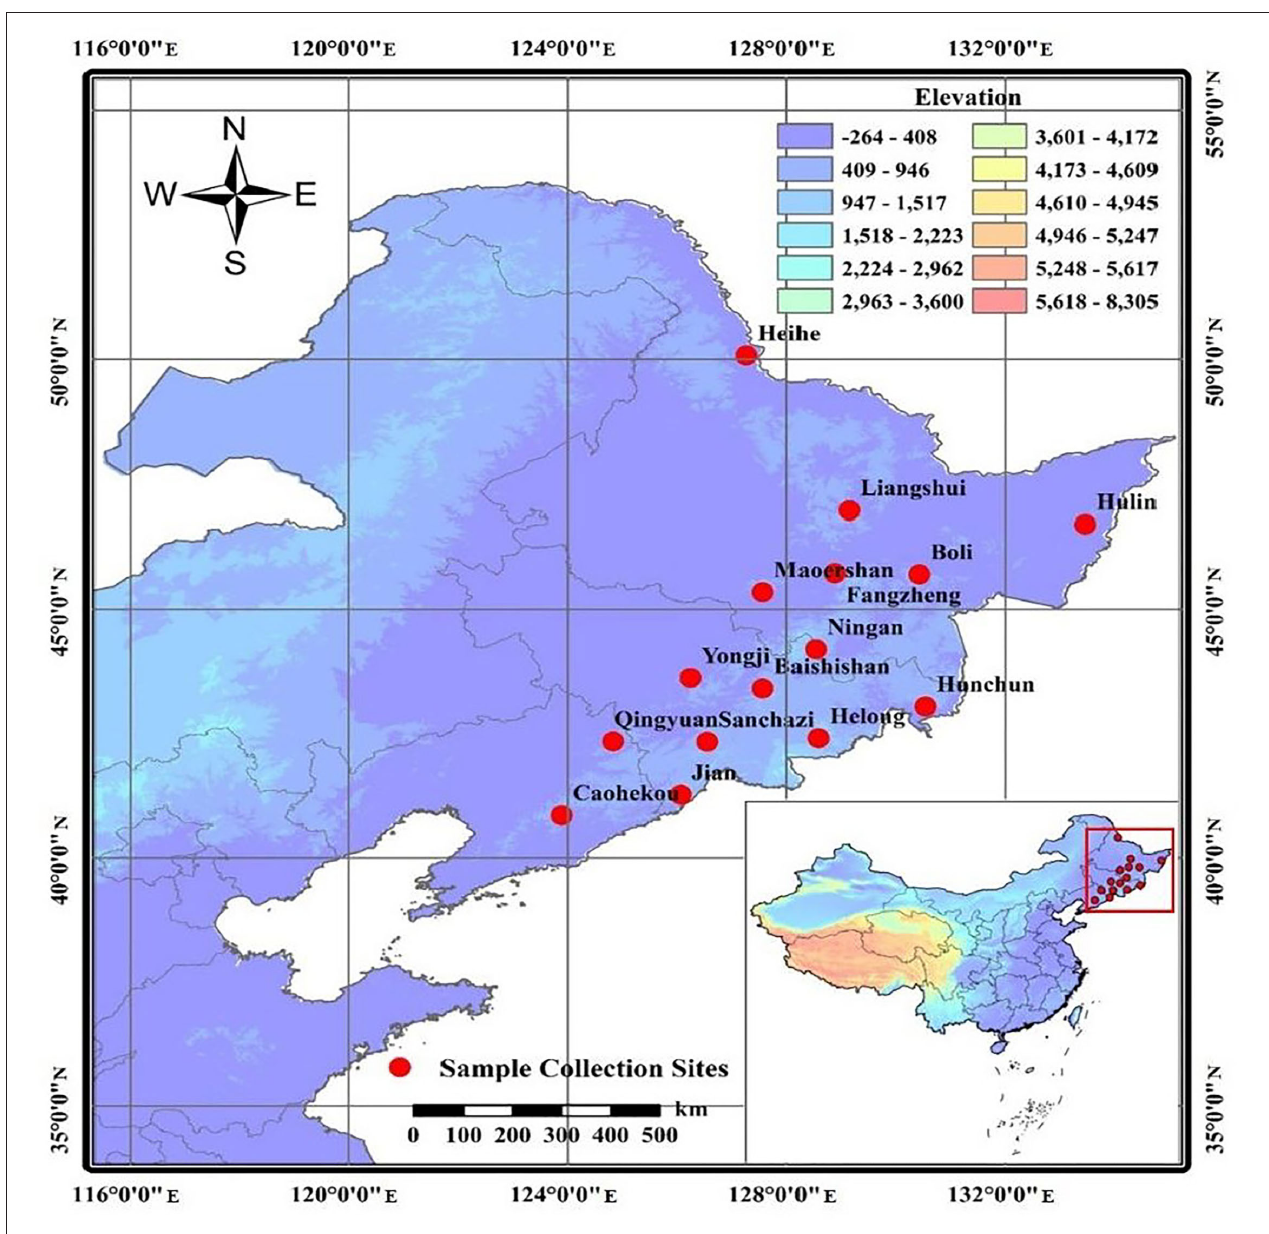
FIGURE 1 | Geographical distribution of Juglans mandshurica collected in Northeast China.